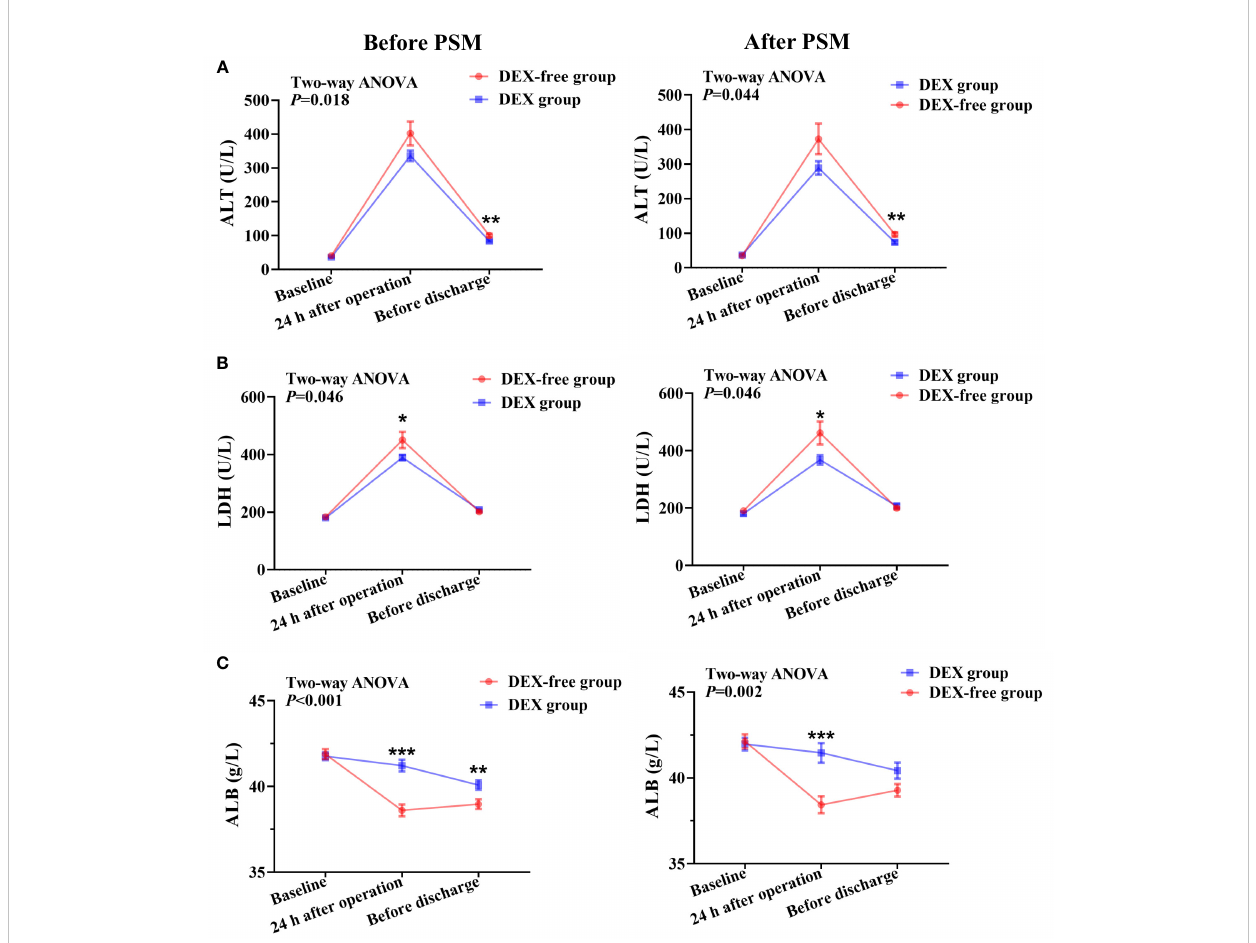
FIGURE 2 Serum levels of biomarkers of liver function at various time points in patients undergoing hepatectomy before and after PSM. (A) , serum ALT levels; (B) , serum LDH levels; (C) , serum ALB levels. Data were expressed as mean ± standard error. *, P < 0.05; **, P < 0.01; ***, P <